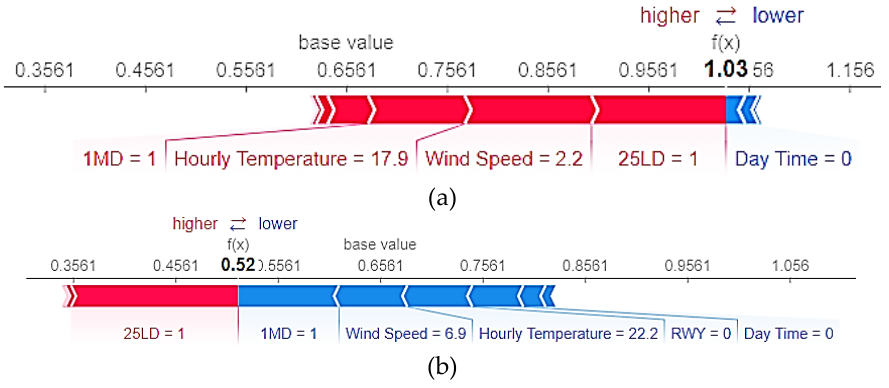
Figure 9. SHAP Explanatory Force Pot: ( a ) Plot for an instance value equals to 1.03; ( b ) Plot for an instance value equals to 0.52.